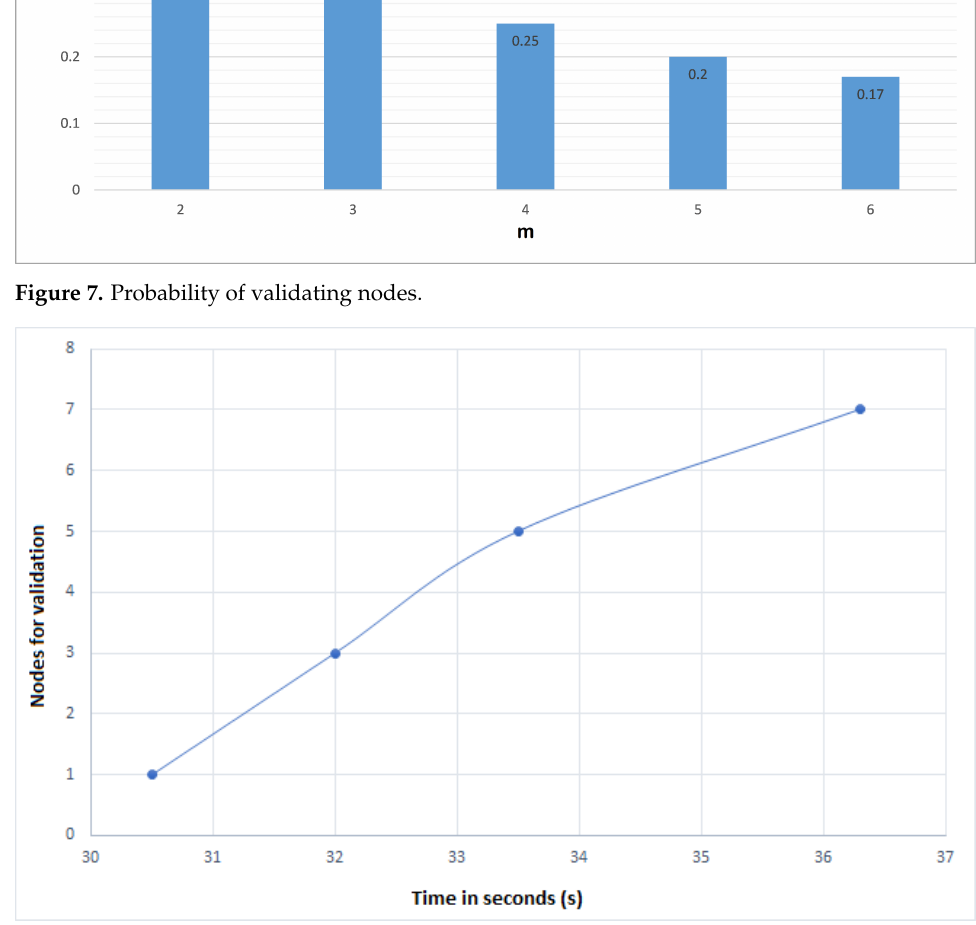
Figure 8. Total time for validation and verification per